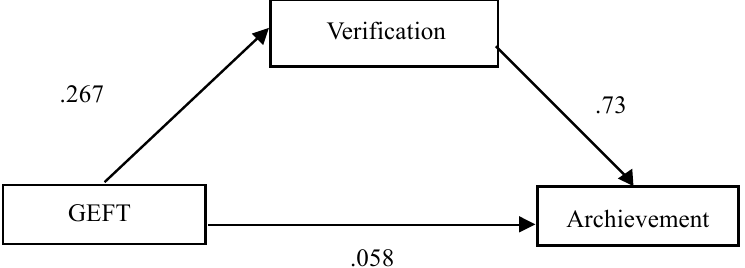
Figure 2. Linear regression analysis performed for the scores on planning strategies, cognitive style and academic